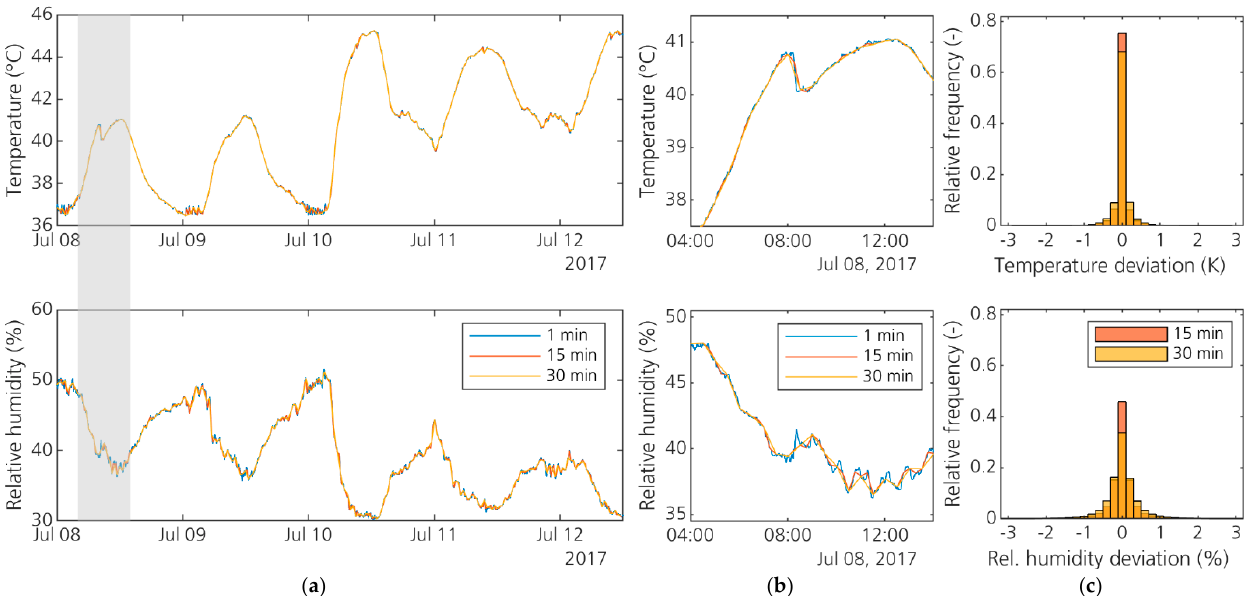
Figure 14. Effect of sampling intervals (1, 15 and 30 min) on the captured dynamics of cabinet-internal temperature and humidity (data from WT3); qualitative comparison of the time series over an example period of several days ( a ) and for a segment of 10 h ( b ); quantitative analysis of the deviations of 15 and 30 min signals from the 1 min time series ( c ).